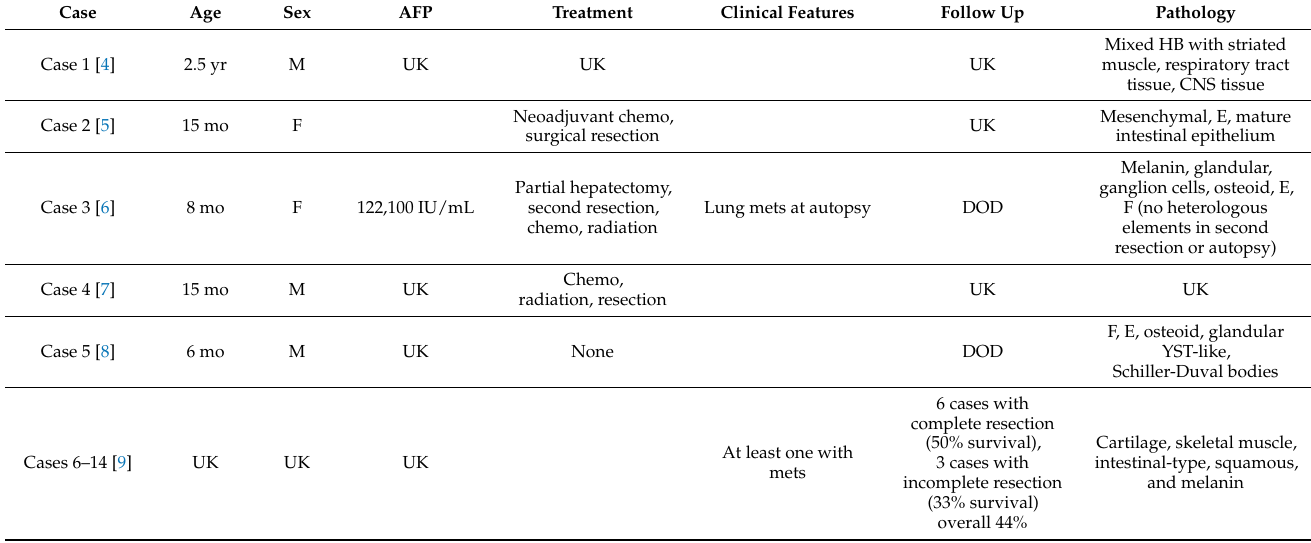
Table 3. Previously reported cases of teratoid HB, mixed HB and teratoma, and mixed HB and